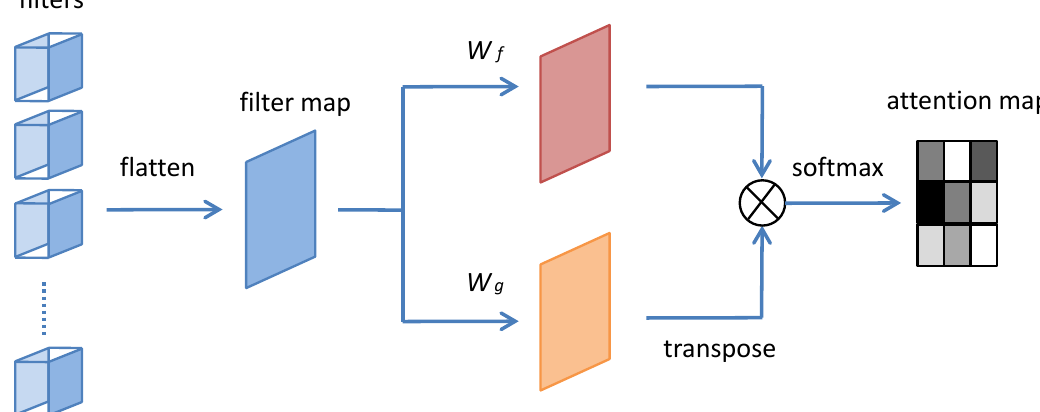
Figure 2. The proposed attention module for PFAM. ⊗ denotes the matrix multiplication. The softmax operation is performed on each